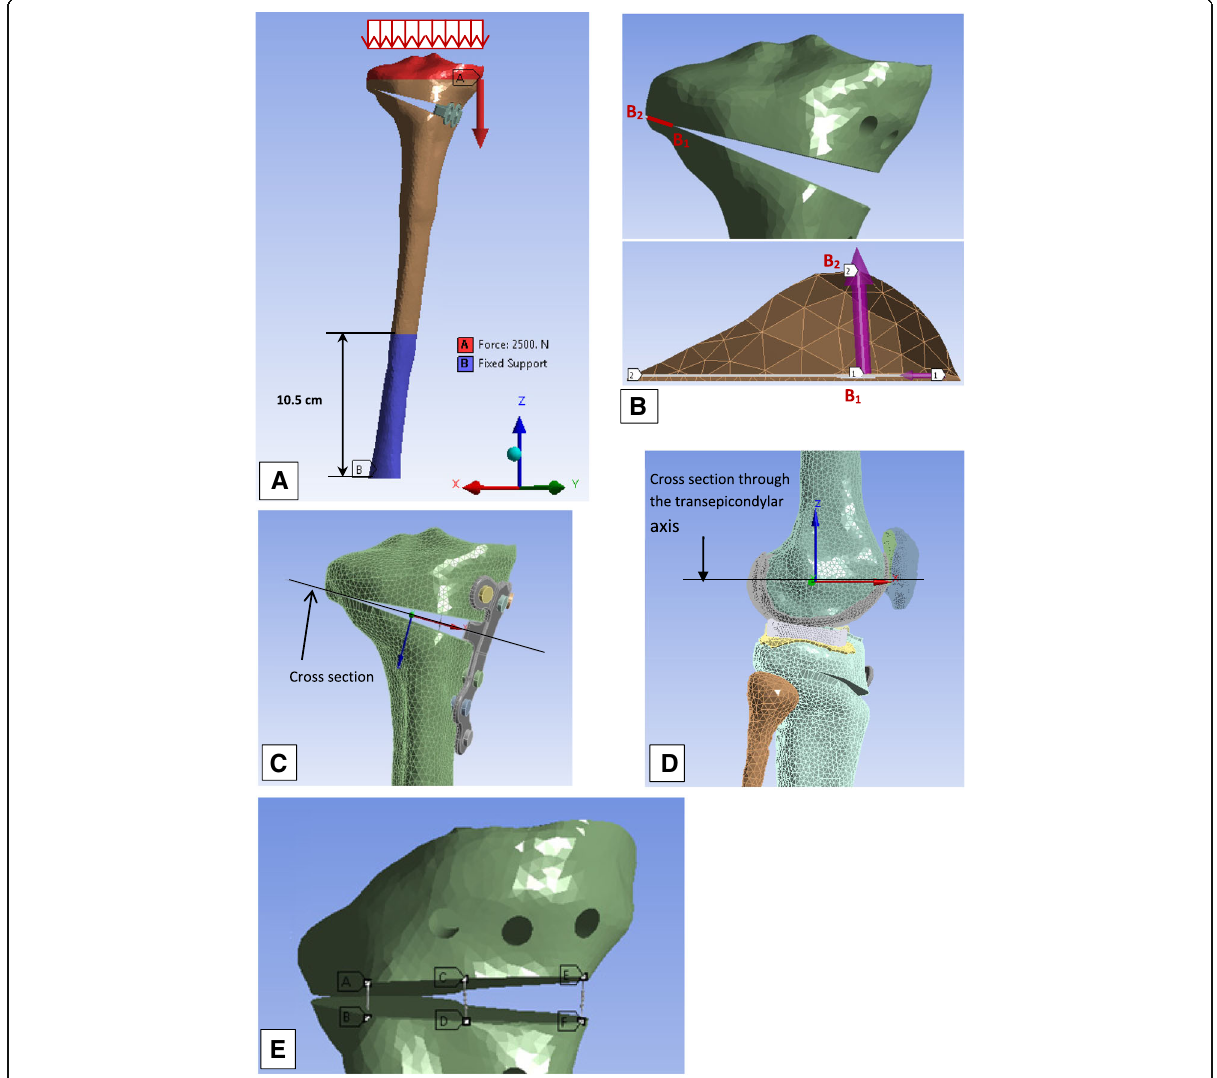
Fig. 2 Loading, boundary conditions and analyses: a Loading and boundary conditions of the simplified loading models. b Cross section of the contralateral cortex and path to check the stresses in the contralateral cortex; B1 and B2 were the starting point and the ending point of the path B1B2 that was chosen and on which the stress distribution was determined. c Cross section where section forces and moments were determined in order to highlight the influence of muscle forces. d Cross section passing through the transepicondylar axis that was defined in order to calculate the section forces in the knee joint. e The three weak springs ( ab, cd and ef ) that were used to quantify the micromovements of the